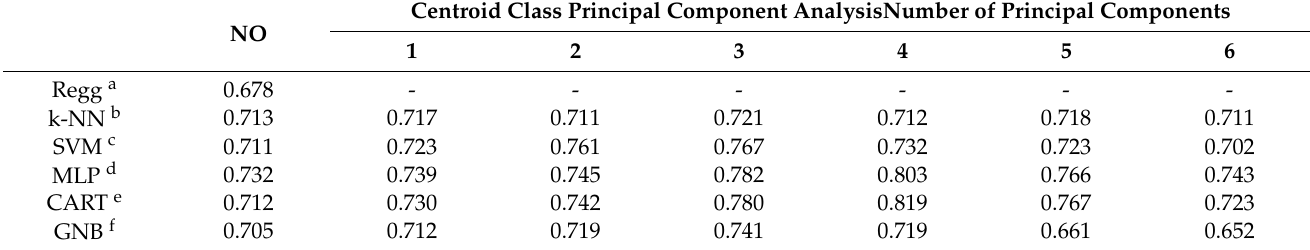
Table 4. Statistics of the accuracy of the depression risk classification.